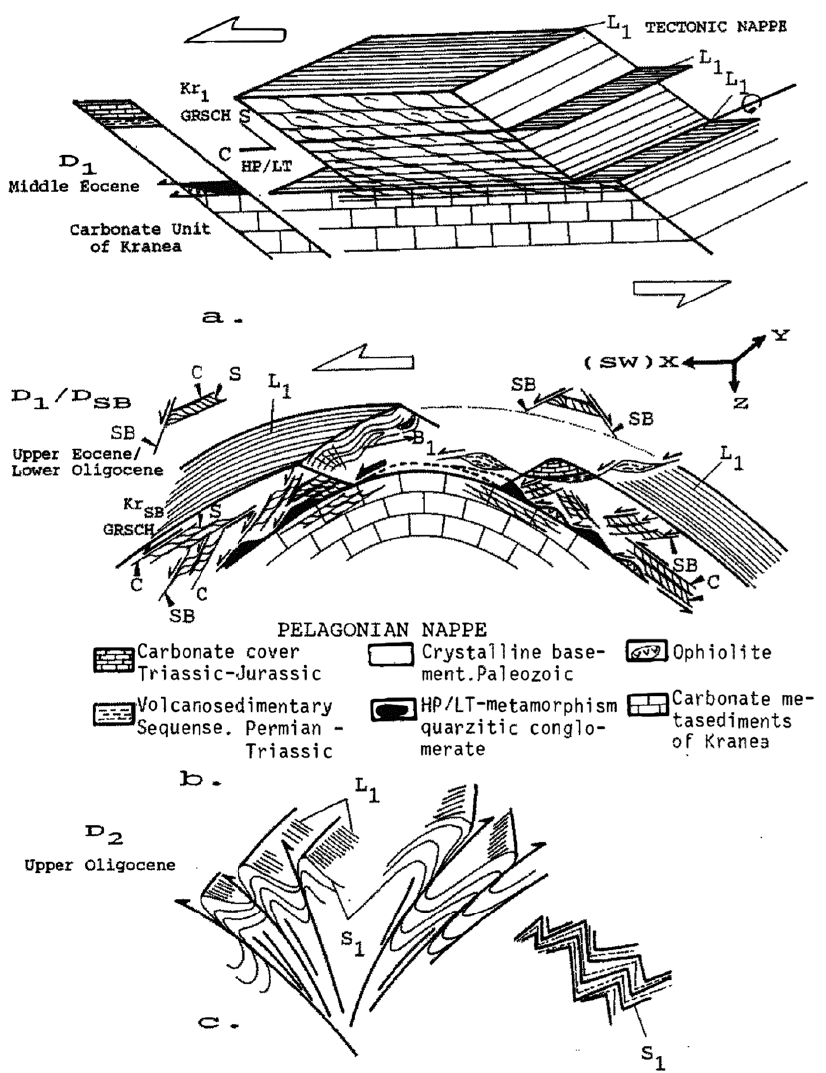
Figure 4. Schematic illustration of the evolutionary stages for the Tertiary deformation in the broader studied region (Kranea area). ( a ) D1 compression and SW-wards nappe stacking, including the HP/LT metamorphic rocks, ( b ) subsequent extension and crustal uplift; kinematic indicators show also a main SW-ward sense of movement during nappe denudation, ( c ) younger D2 compression, conjugate knick-folds and SW- or NE-ward directed thrust faults formation (detail explanation in text). After Kilias et al.